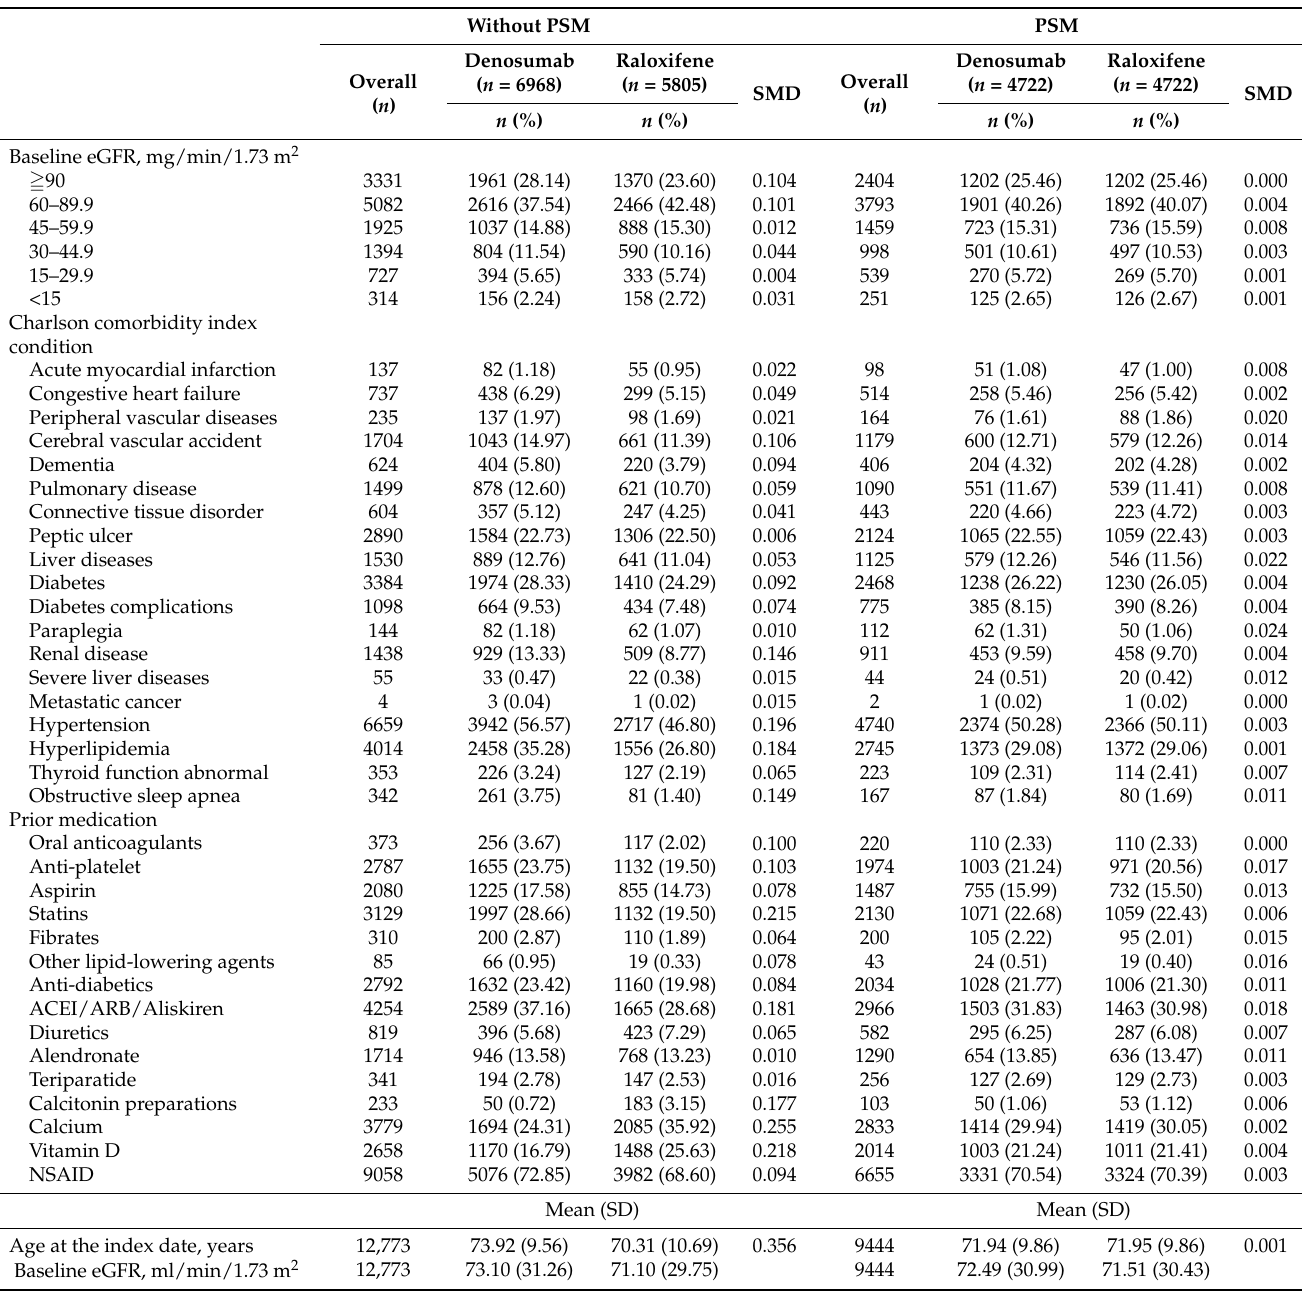
Table 1. Characteristics of study cohort. PSM: propensity score matching; SMD: standardized mean difference, SMD < 0.1 was considered as no sign of imbalance; NSAID = Nonsteroidal anti- inflammatory drugs; ACEI: Angiotensin converting enzyme inhibitor; ARB: Angiotensin recep- tor